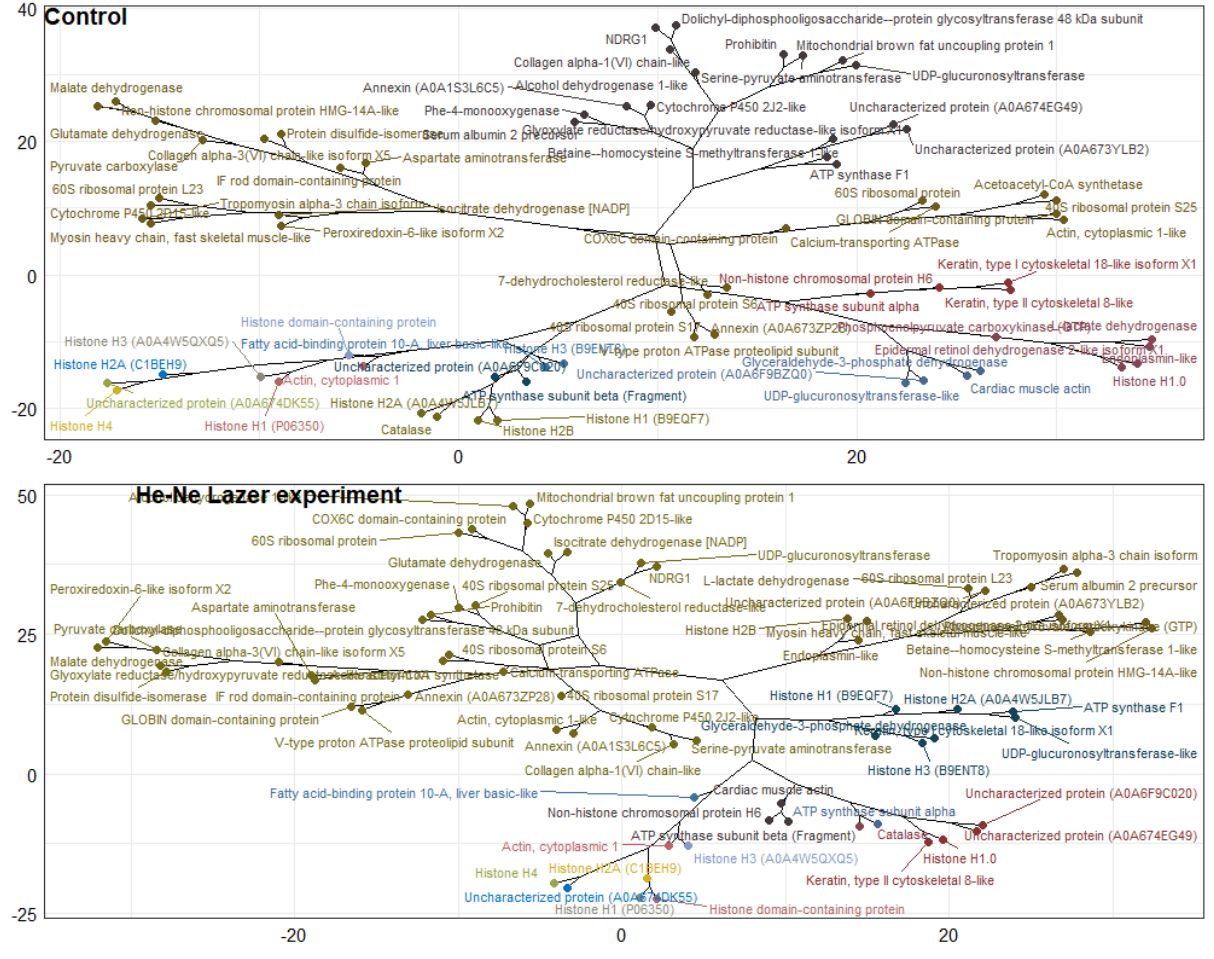
Figure 16. Hierarchical clustering visualizing as a “phylogenetic tree dendrogram” for control and experimental groups of underyearlings ofAtlantic salmon ( Salmo salar L.). Note: 15 clusters are pick out.